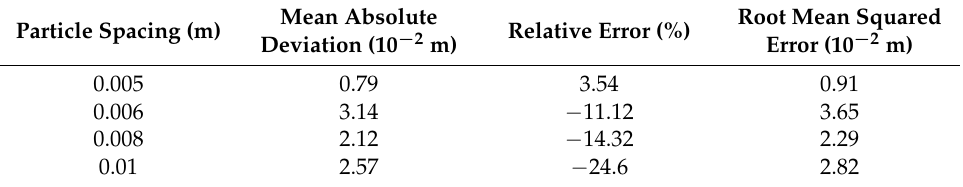
Table 9. Errors of the SPH-estimated water-surface profiles with respect to the experimental